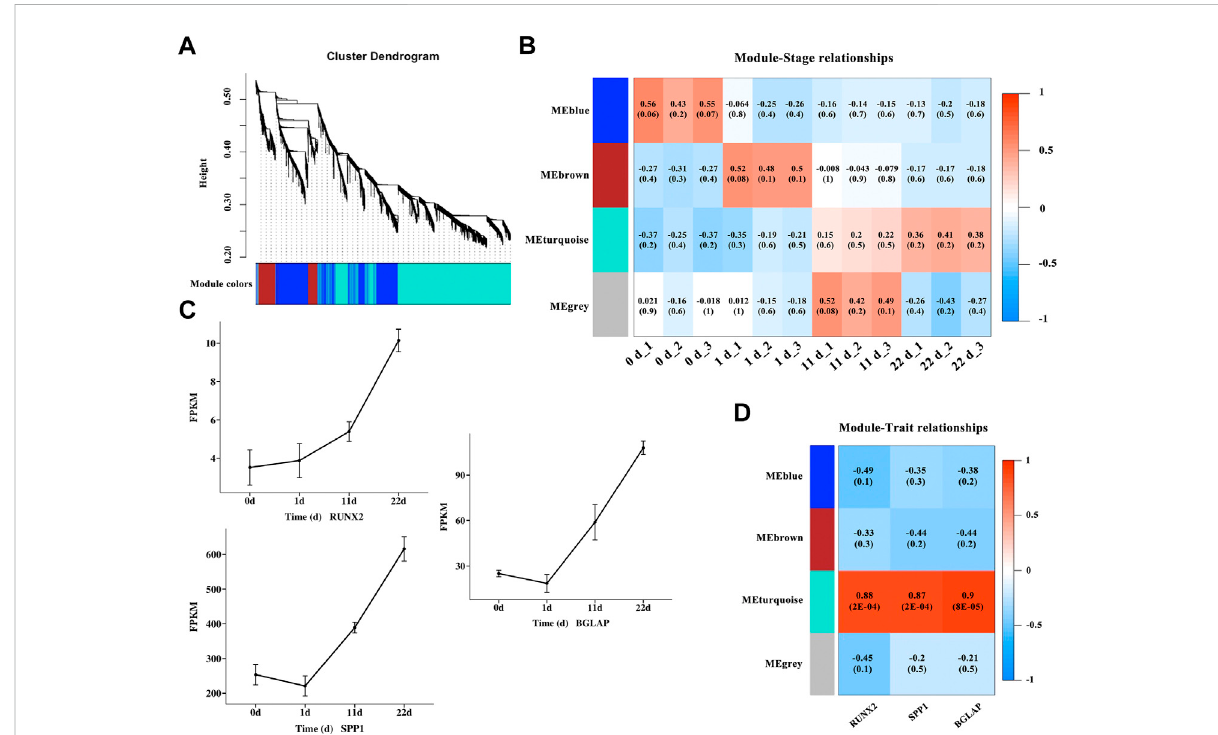
FIGURE 4 Identi fi cation of modules associated with osteogenic differentiation in different induction stages. (A) Clustering dendrogram of DEGs in different osteogenic induction groups. As a result, 4 modules with different colors were constructed. (B) Module-trait association and the corresponding p -value with all theDEGs(listedin SupplementaryTable S4)atdifferentosteogenic induction time. (C) The mRNA variation tendency of genes RUNX2, SPP1 and BGLAP. Horizontal coordinate represents the induction time. The ordinate represents the changes of fragments per kilobase per million (FPKM). (D) Module-gene correlations and the corresponding p -value of genes RUNX2 , SPP1 and BGLAP